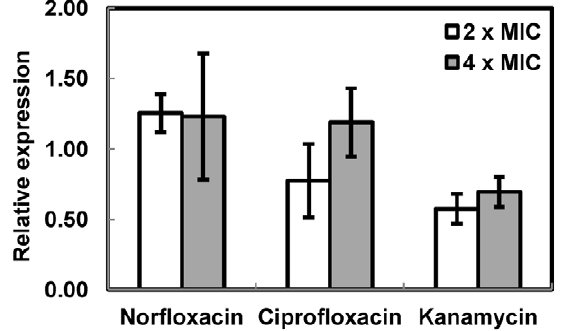
Figure 8. Relative expression of bc4707 in stressed cells compared to unstressed cells. The expression level of bc4707 was measured by qRTPCR and was normalized against the expression of16S RNA. The values shown are ratios of the normalized expression levels of cells stressed with antibiotics for 15 min compared to unstressed cells. Shown are averages and standard deviations of at least two independent experiemnts each done with two technical replicates.